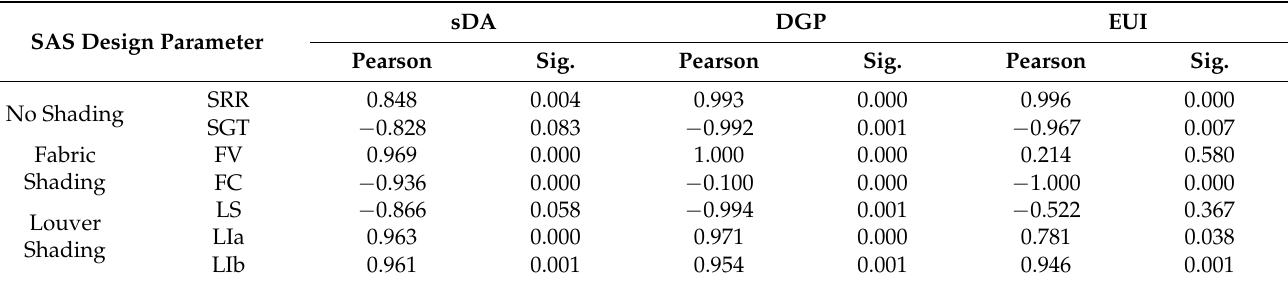
Table 9. Correlation analysis of atrium